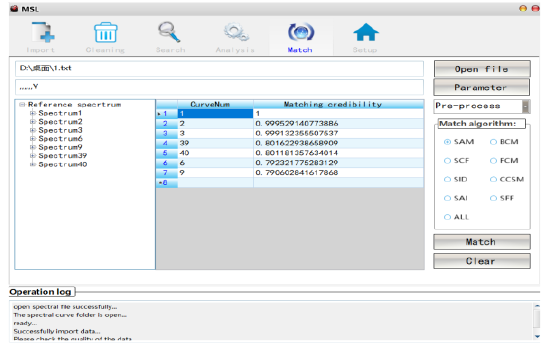
Figure 13. The data analysis